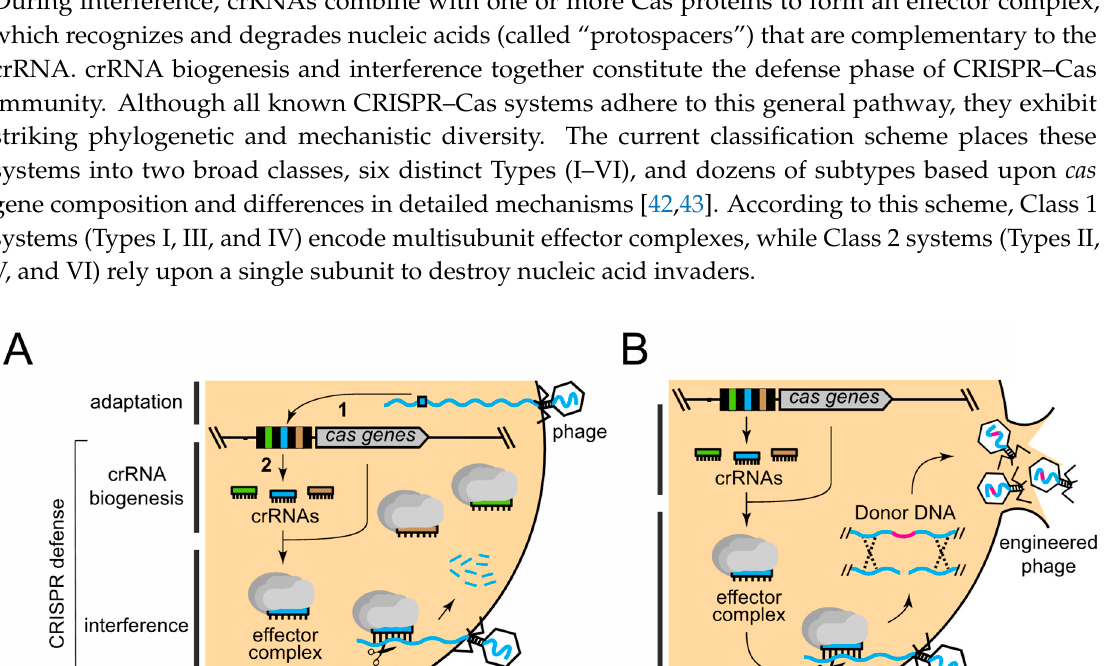
editing outcomes are described in the sections